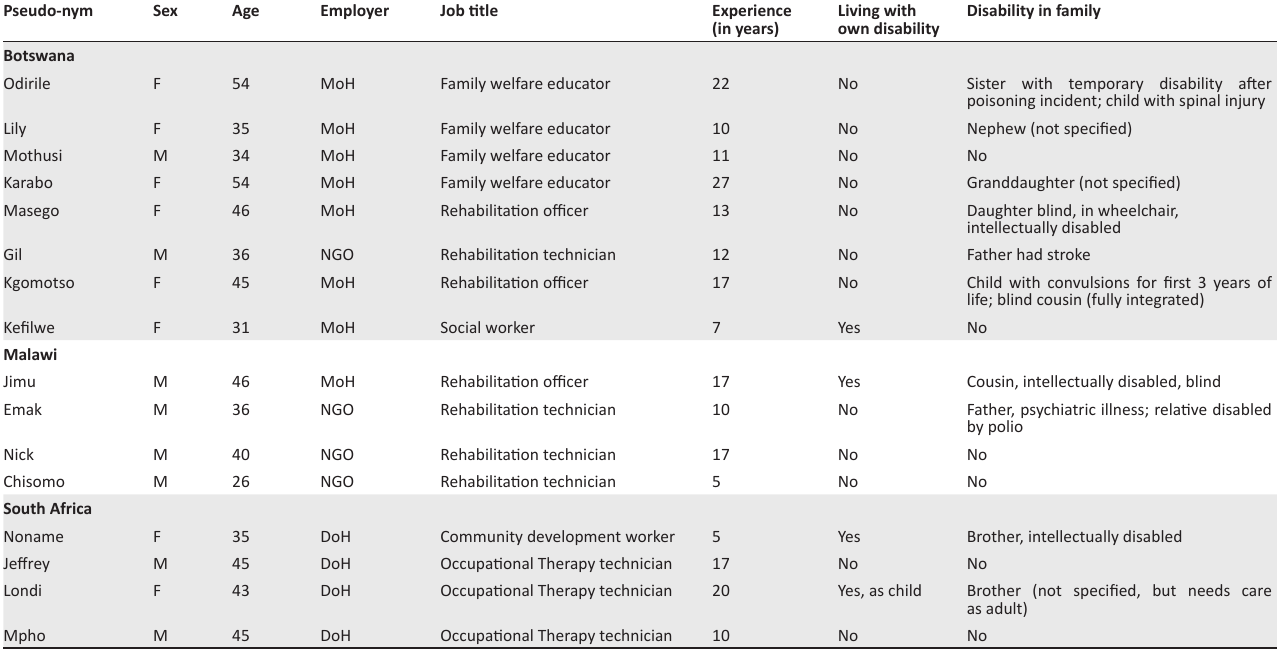
TABLE 1: Profile of participants (community disability workers).